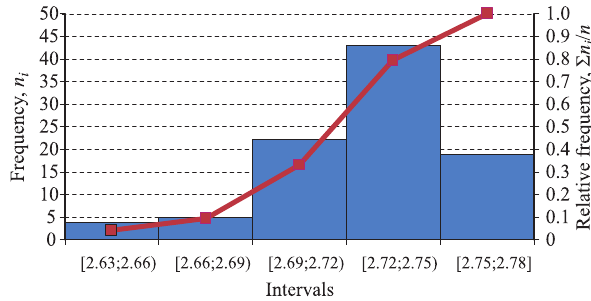
Fig. 8. Histogram of density ρ rd of crushed dolomite (fr. 8/12.5 mm) and distribution